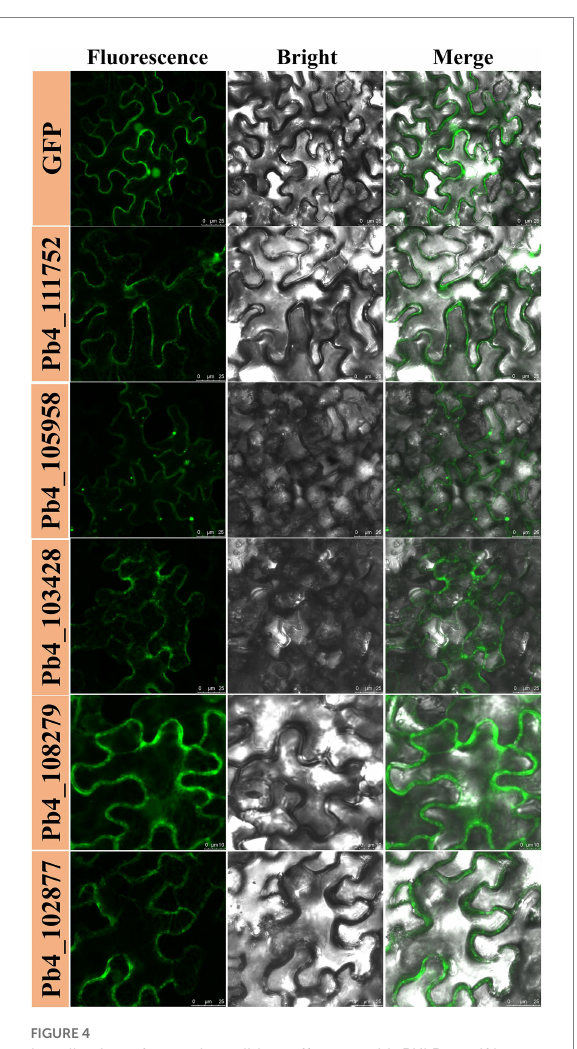
FIGURE 4 Localization of several candidate effectors with RXLR motif in Nicothiana benthamiana